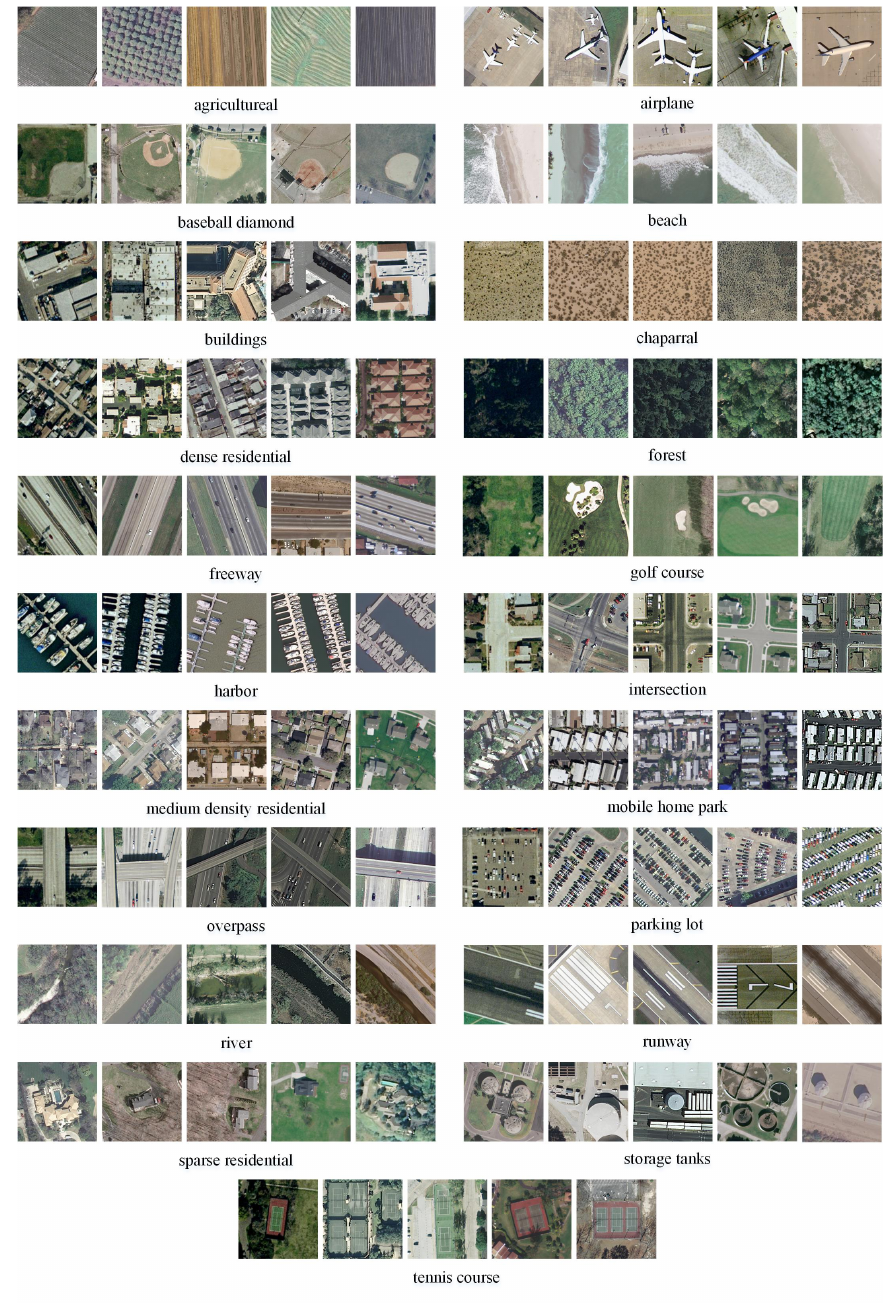
Figure 7. Samples from UCMERCED. Example geographic images associated with 21 categories are shown